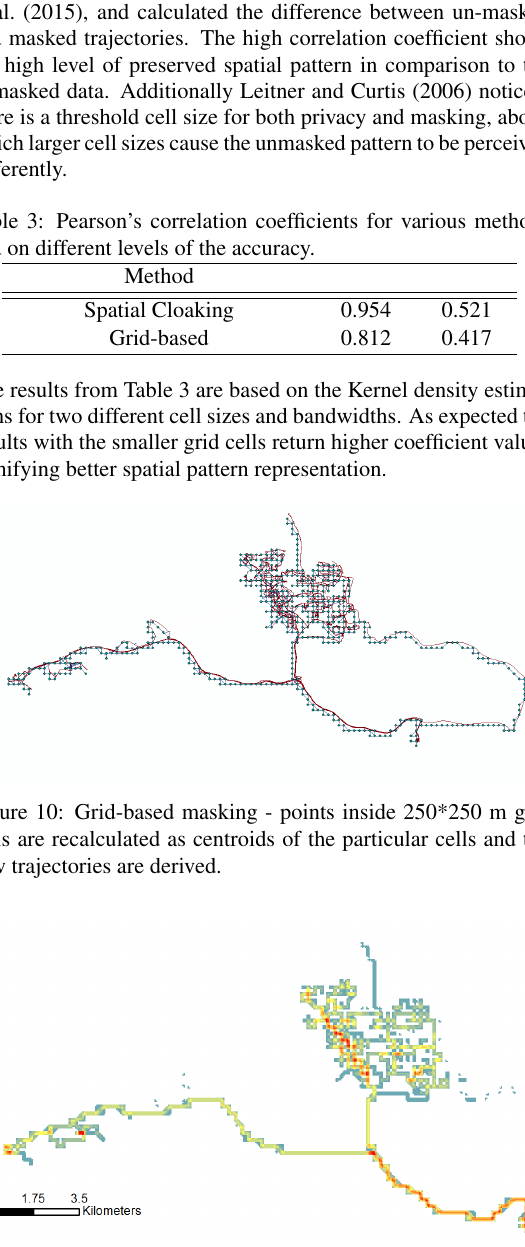
Figure 11: Generalisation of grid-masked trajectories - KDE for the trajectories derived using